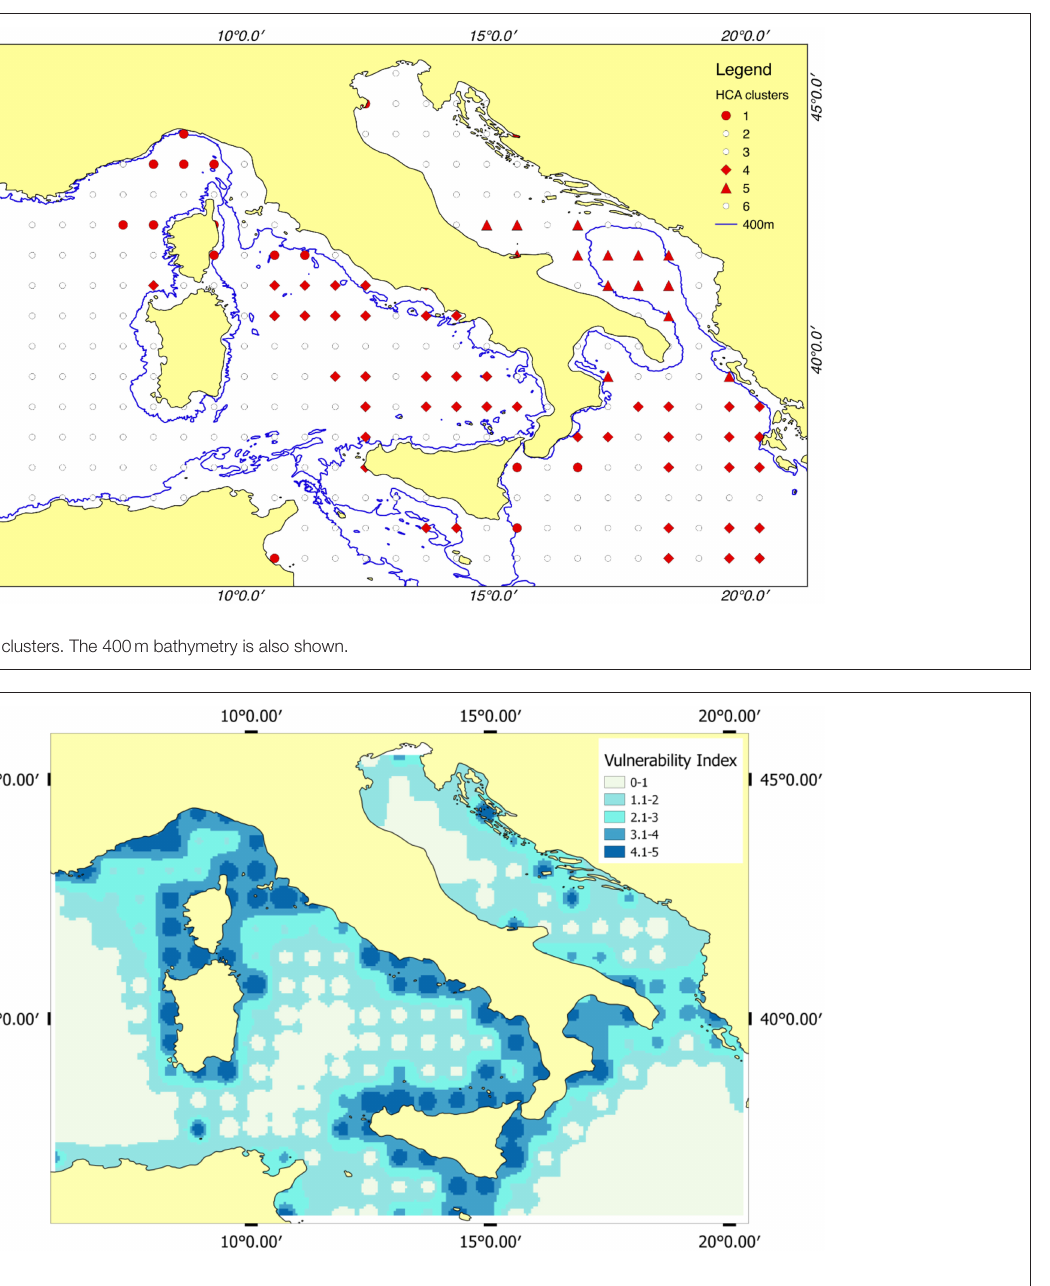
FIGURE 10 | Map of the Vulnerability Index